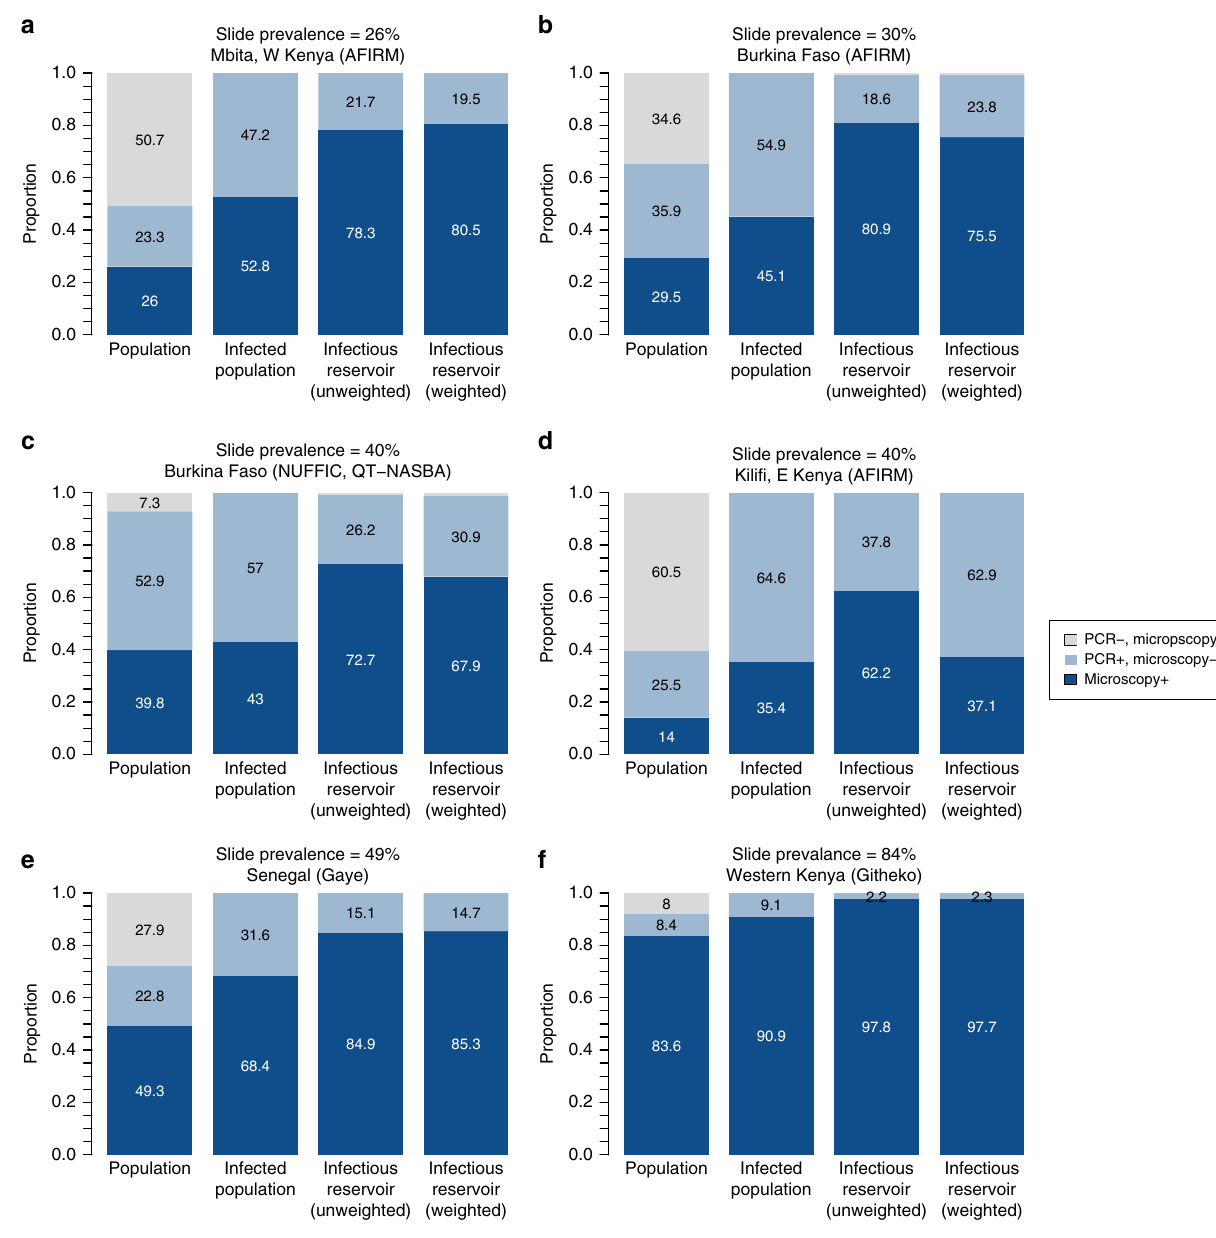
Fig. 7 Contribution to the infectious reservoir of individuals with microscopic and subpatent infections. The results are shown for data from six study locations 3 – 5, 40 . The fi rst column in each panel shows the proportion of the population that are infected with microscopy or RDT detectable and undetectable asexual parasites. The second column shows how these two groups make up the infected population. The third column shows the unweighted contribution to the infectious reservoir of the two groups, accounting for the proportion of people in each group and their relative infectivity to mosquitoes. The weighted infectious reservoir shown in the fourth column additionally accounts for the relative biting frequency (based on their age and probability of using a bednet) of individuals and corrects for the age distribution of participants in each study. Source data are provided as a Source Data fi Methods ● falciparum AND (densit* OR quantitative) AND (LAMP OR loop- Systematic review . There are three main topics within our review (see below) mediated isothermal ampli fi cation OR thermophilic helicase dependent ampli fi cation OR tHDA OR recombinase polymerase ampli fi cation and we designed speci fi c search strategies for each. Abstracts of publications OR RPA) within PubMed were searched for the speci fi c terms below. The authors also sought relevant unpublished data as far as possible within the time frame of the review. 1. Density and detectability of P. falciparum infections: search after 01/11/2011 (date at which previous systematic review 1 was completed) for: ● falciparum AND (densit* AND (pcr OR polymerase chain reaction)) OR “ quantitative pcr ” OR “ quantitative polymerase chain reaction ” OR qpcr OR “ real time pcr ” OR real time polymerase chain reaction OR NASBA